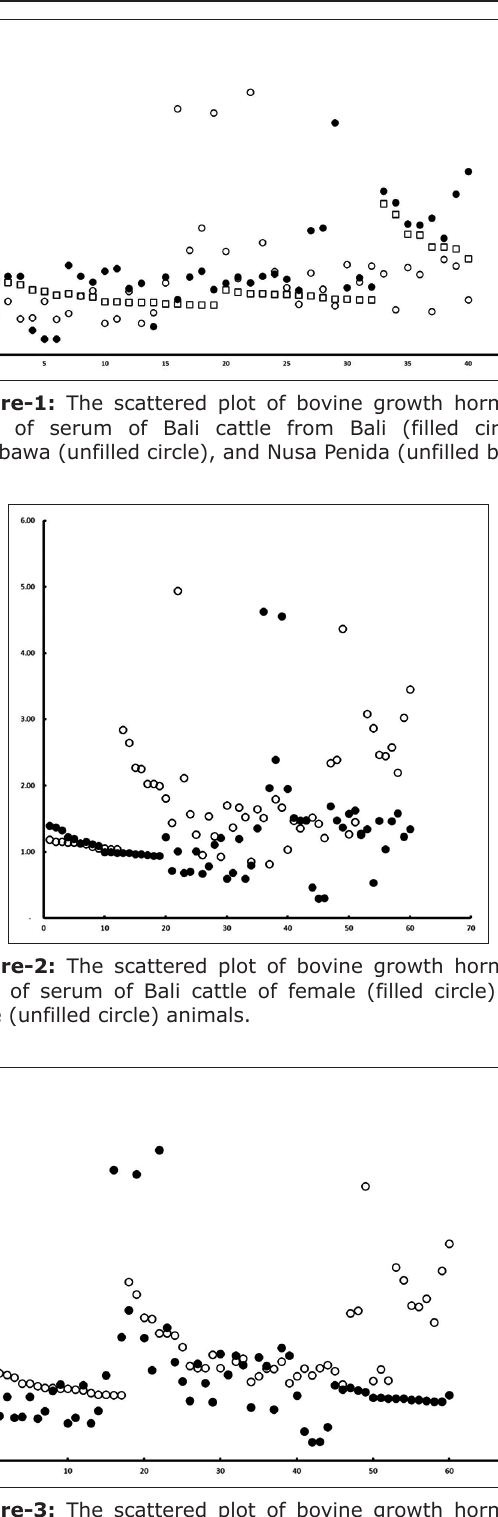
Figure-3: The scattered plot of bovine growth hormone level of serum of Bali cattle of free grazing (filled circle) and install (unfilled circle) animal